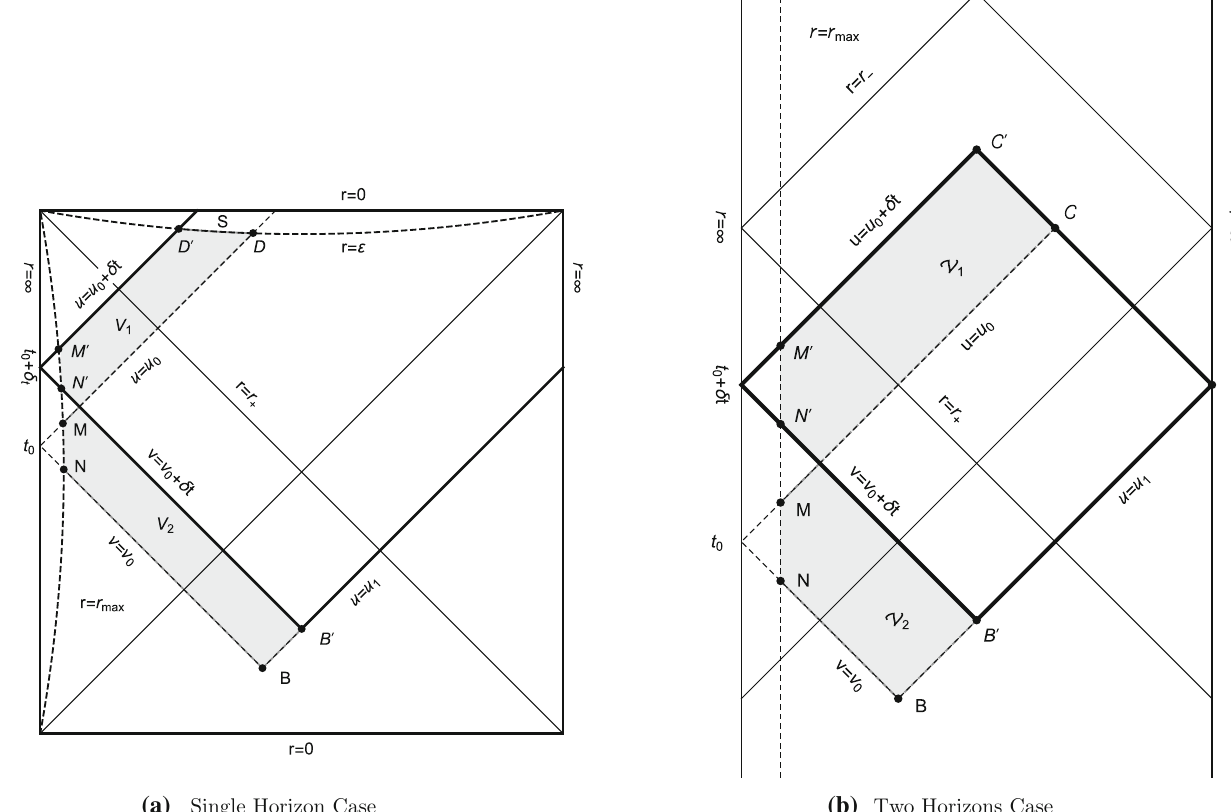
Fig. 7 Wheeler–deWitt patches of Born–Infeld AdS black holes at t L = t 0 and t L = t 0 + δ t . The lines r = r max and r = ε are cut-off surfaces